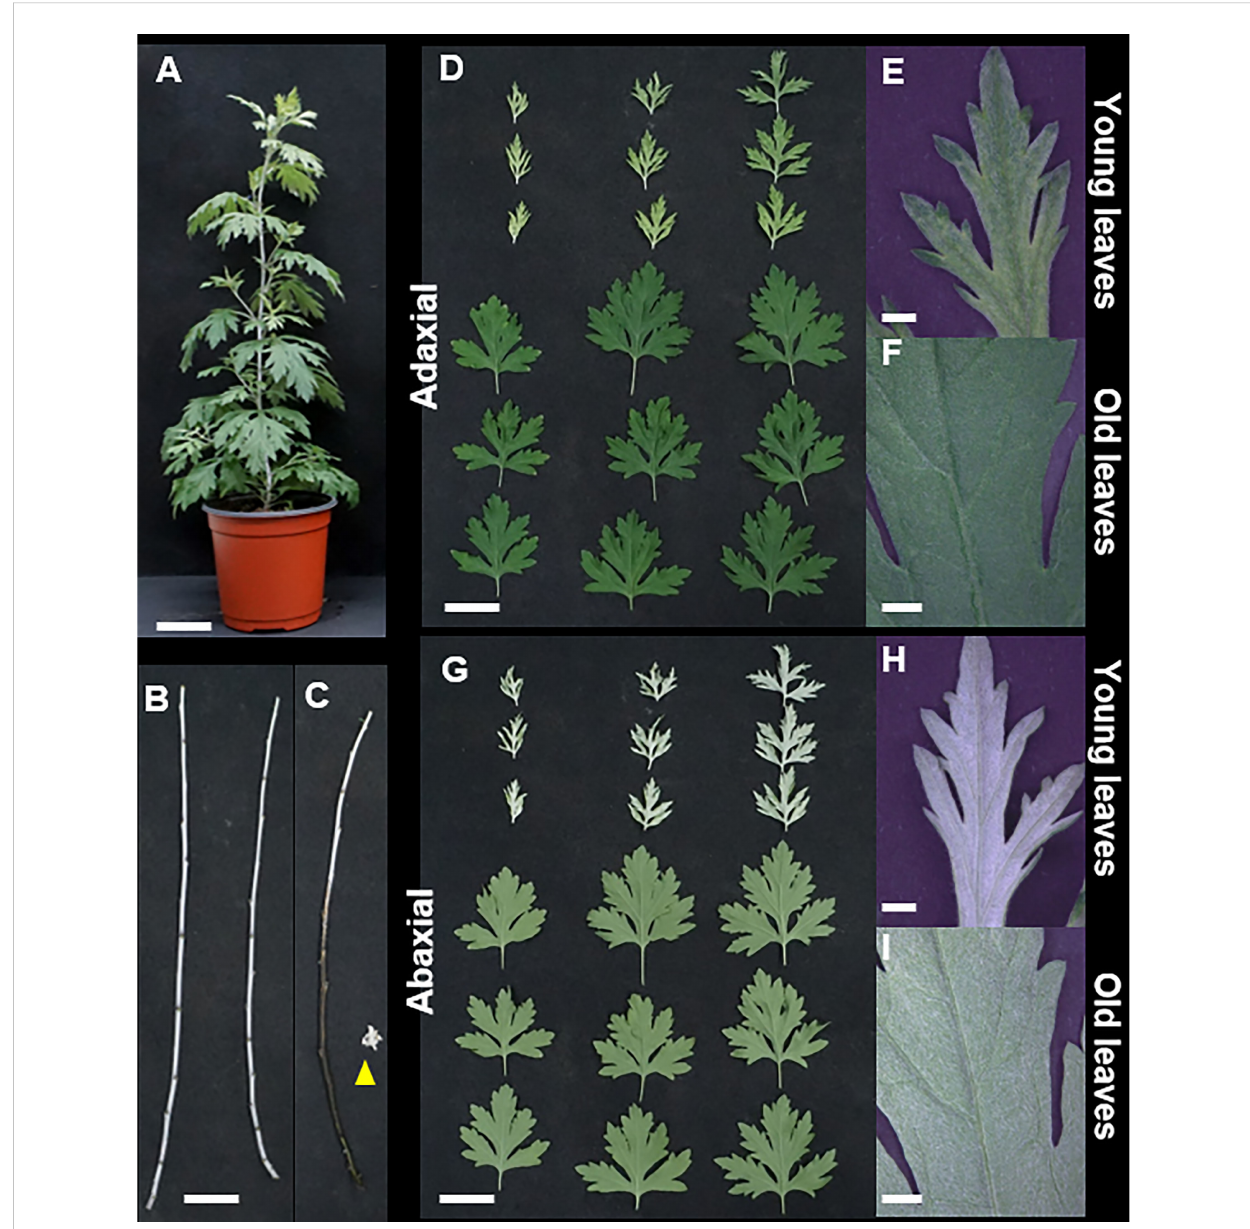
FIGURE 1 Morphological characteristics of Artemisia argyi . (A) Whole plant. (B) Stems. (C) The part where trichomes have been removed from the stem appears black, and the yellow triangle indicates the stripped trichome. (D-F) . Adaxial leaf surfaces in young and old leaves. (G-I) Abaxial surfaces in young and old leaves. Scale bars; (A-D) , G = 5 cm, (E, F, H, I) = 1